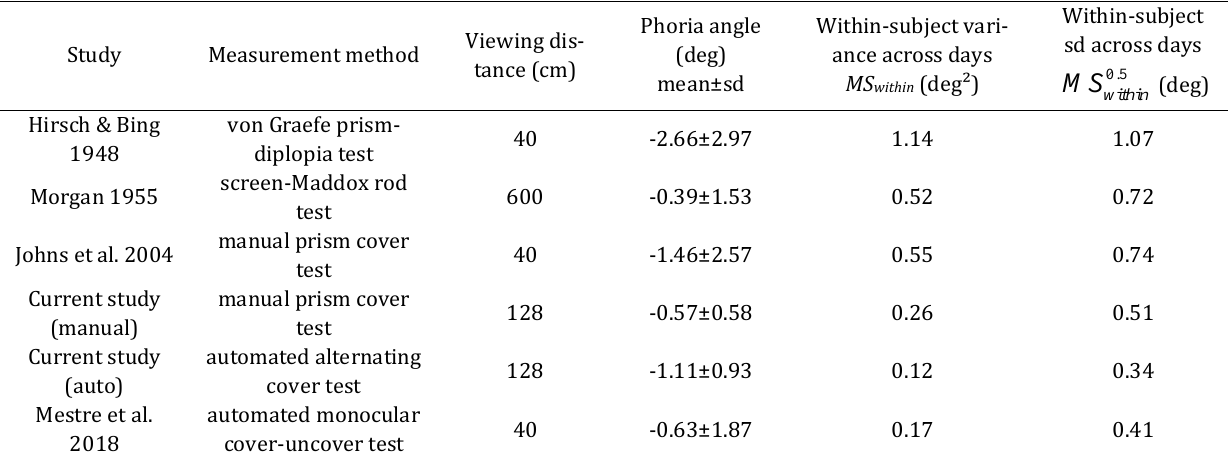
Table 3: Comparison of within-subject variability between studies: